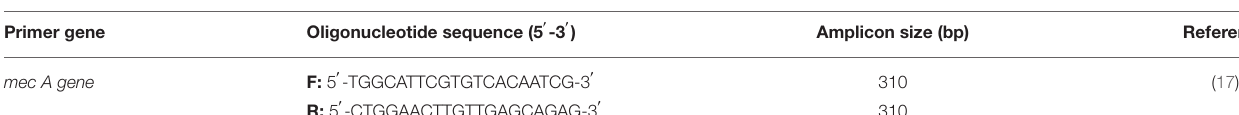
TABLE 1 | Nucleotide sequence of the primers used for detection of mecA gene.